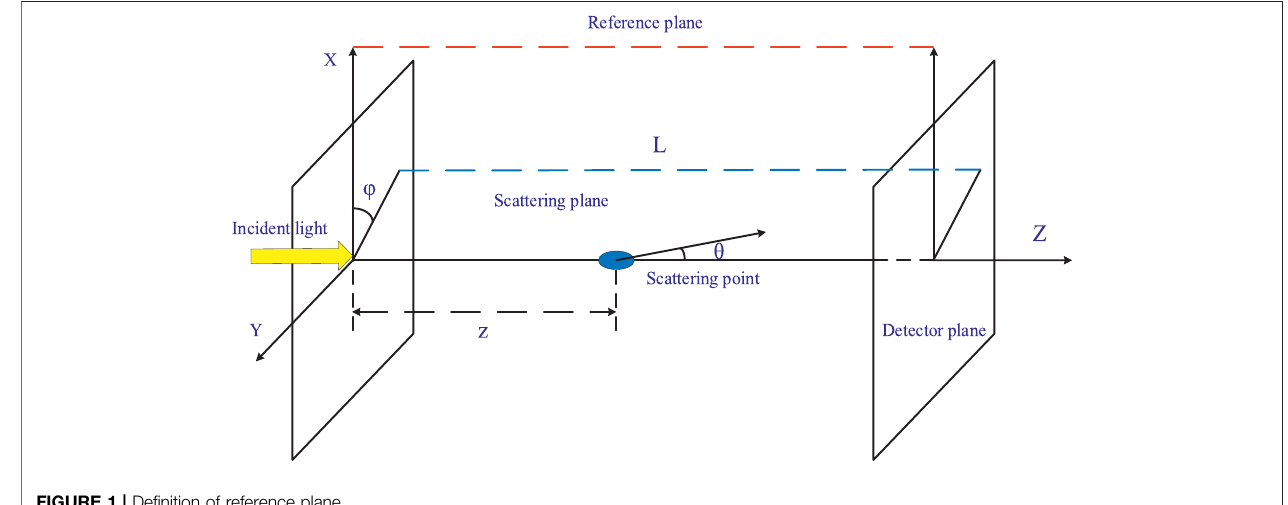
FIGURE 1 | De fi nition of reference plane.